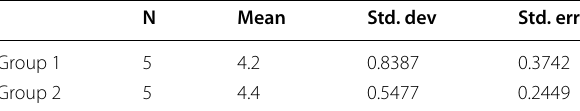
Table 6 Summarized statistics from the group observations from organizations and public domains on perceptions of risks & mitigation, climate change, brand culture and relationship